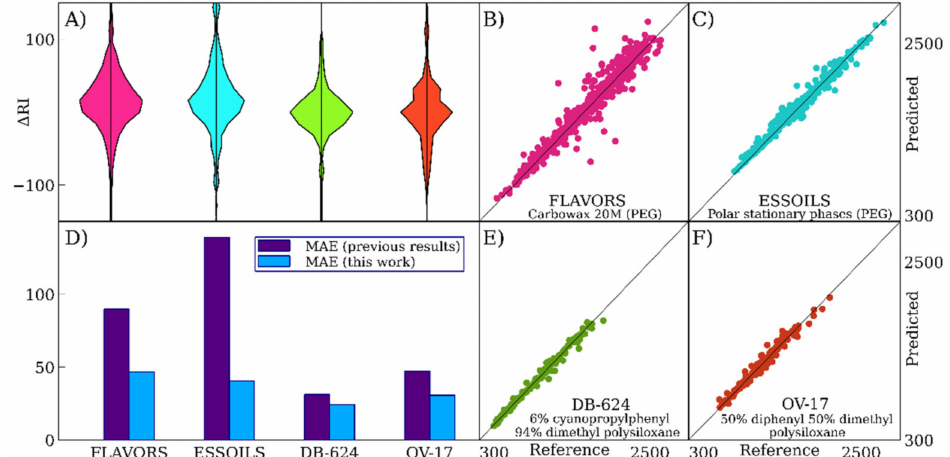
Figure 3. The accuracy of retention index prediction for various data sets and stationary phases. ( A )—distributions of errors for various data sets. ( B , C )—predicted versus reference values for FLAVORS and ESSOILS data sets (polar stationary phases). ( D )—a comparison with the previously published results [11,24–26]. ( E , F )—predicted versus reference values for DB-624 and OV-17 data sets (mid-polar stationary